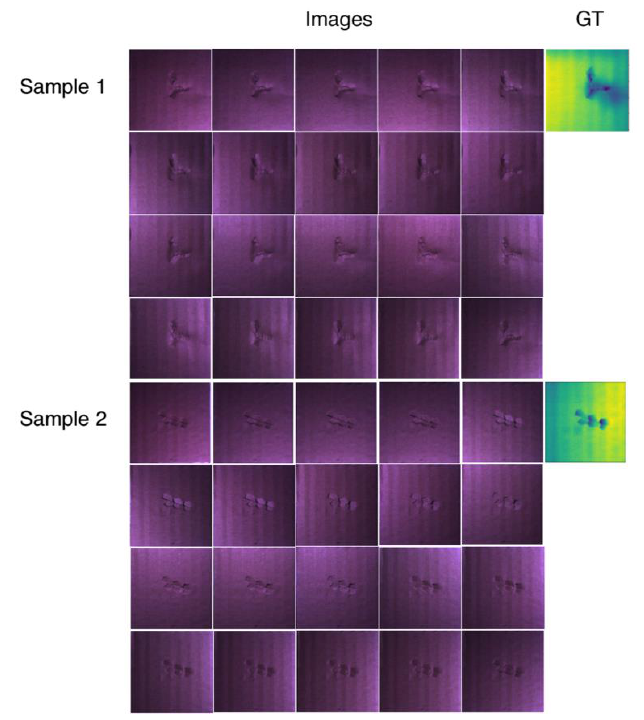
Figure 4. Examples of the collected images and their corresponding ground truth (GT).